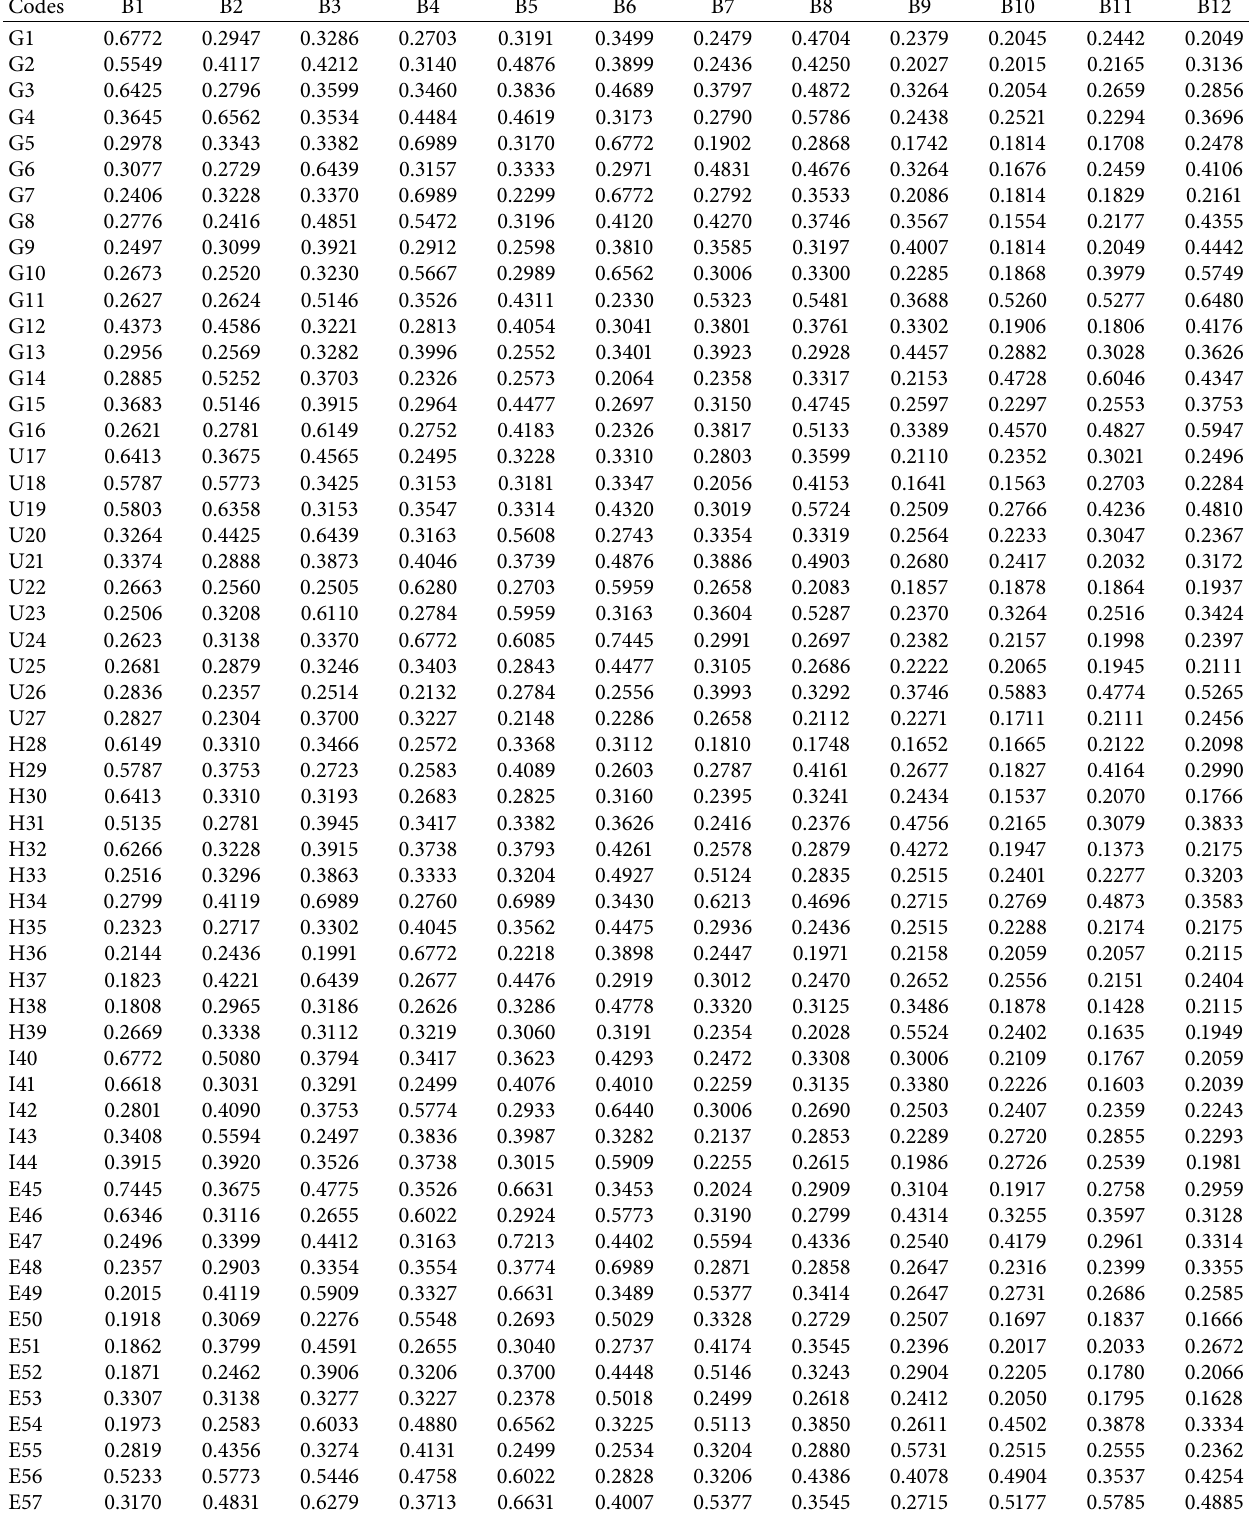
Table 6: Defuzzified aggregate decision